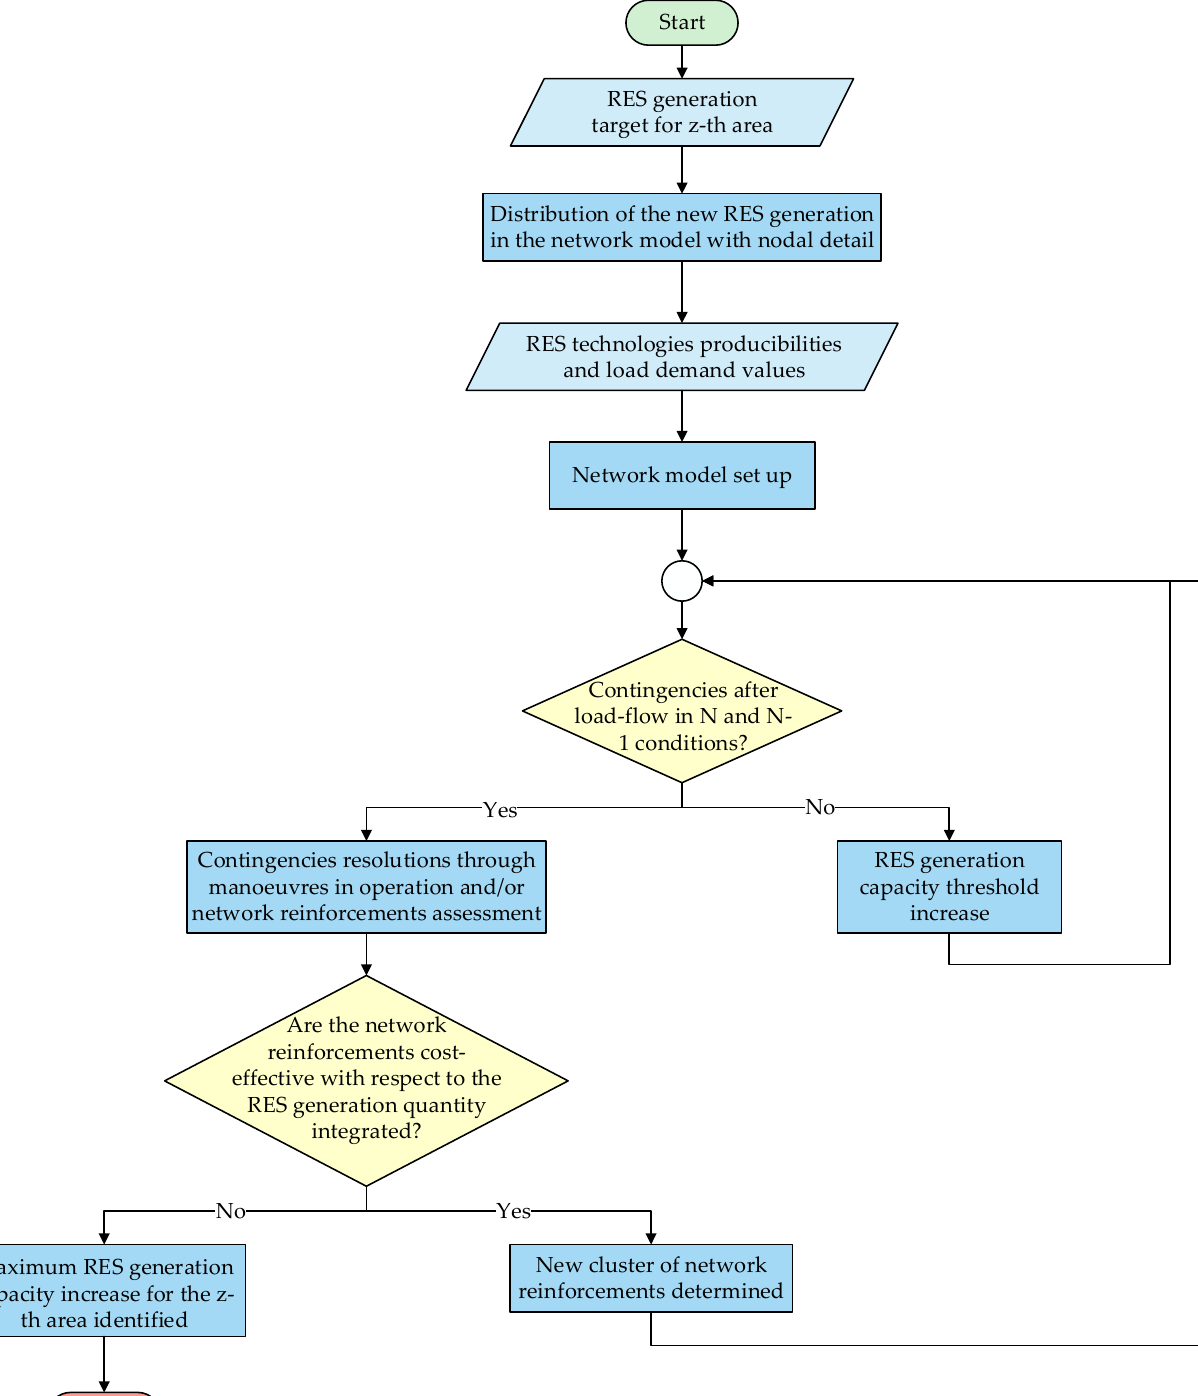
Figure 6. Workflow of the proposed iterative process.